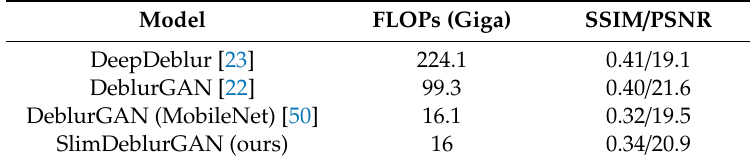
Figure 10. Comparison of DeepDeblur, DeblurGAN, DeblurGAN (MobileNet), and our proposed model of SlimDeblurGAN, in terms of motion deblurring accuracy and the number of FLOPs. Table 8. Comparison of the number of FLOPs and accuracies of Deep Deblur [23], DeblurGAN [22], DeblurGAN using MobileNet [50], and our proposed model, SlimDeblurGAN.